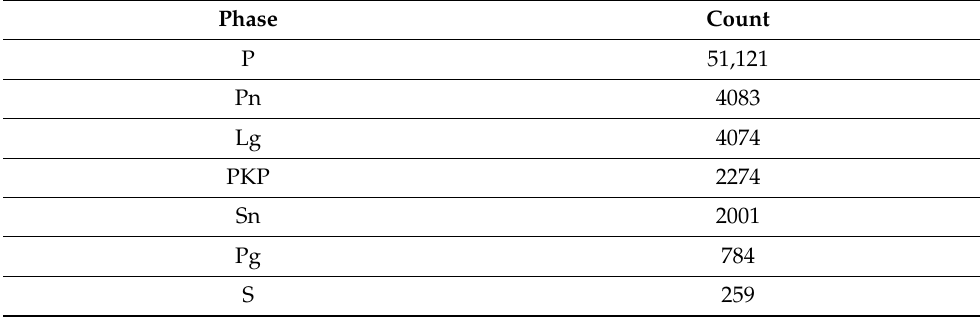
Table 1. Types of phases selected and their distributions.